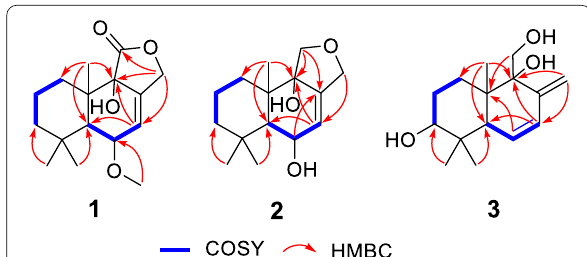
Fig. 2 Key 1 H– 1 H COSY and HMBC correlations of compounds 1 –